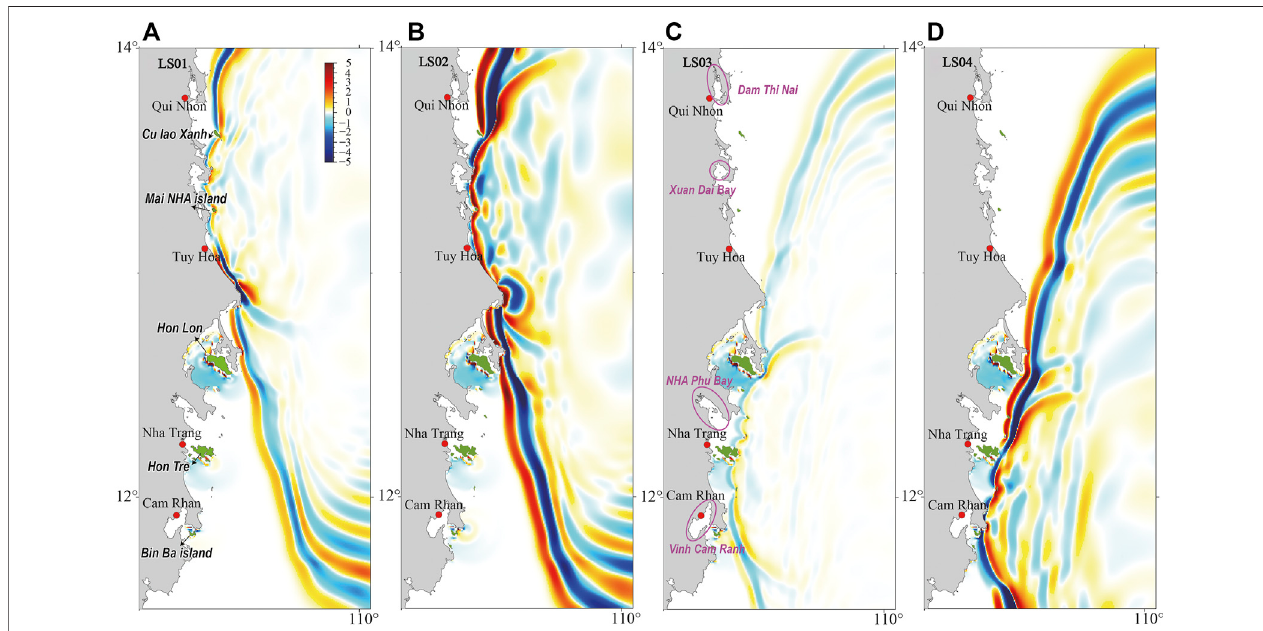
FIGURE 8 | Nearshore propagation of tsunami waves generated by rigid slump of (A) LS01; (B) LS02; (C) LS03; (D) LS04. Red dots : major cities in central Vietnam coast. Green polygons indicate the locations of nearshore islands mentioned in the context. Bays mentioned in 5.2 are marked by purple circles .